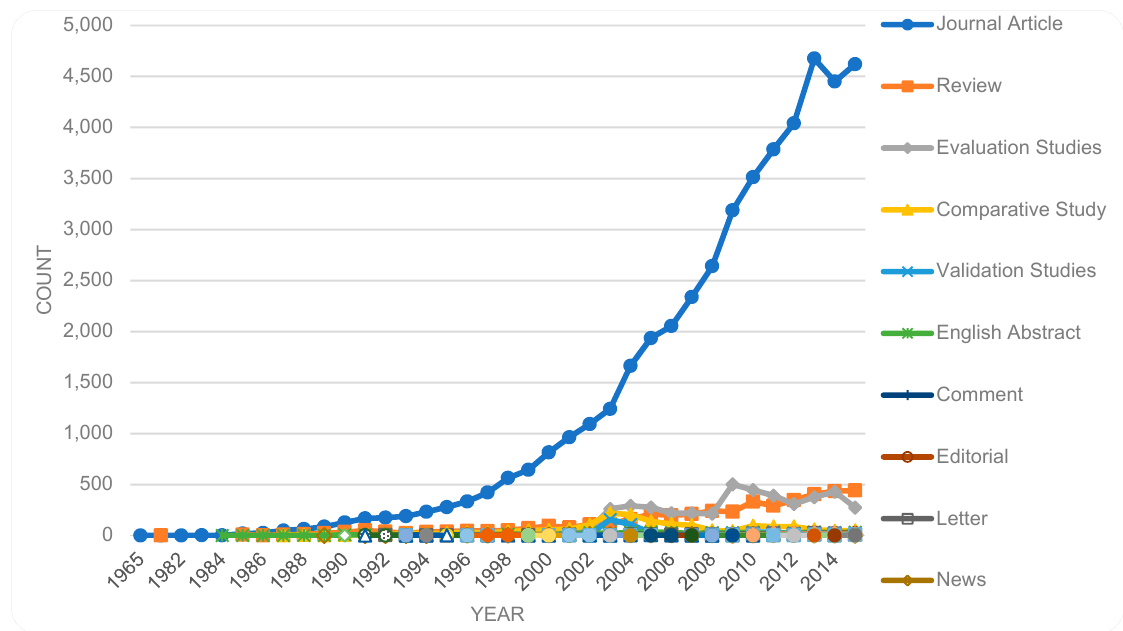
Figure 6. Publication types and their trends over the years.